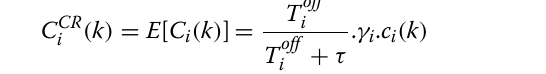
Interference with sensing internal PU